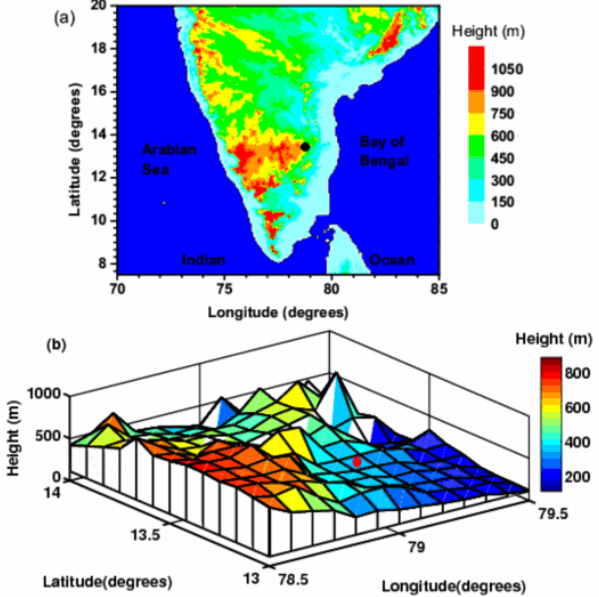
Fig. 2. (a) Topography map of peninsular India (EROS data). Filled circle shows the location of NARL, Gadanki (13.5 ◦ N, 79.2 ◦ E, 335m above m.s.l.) where SAFAR campaign is being carried out. (b) High resolution topography map for 50 km radius around Gadanki.